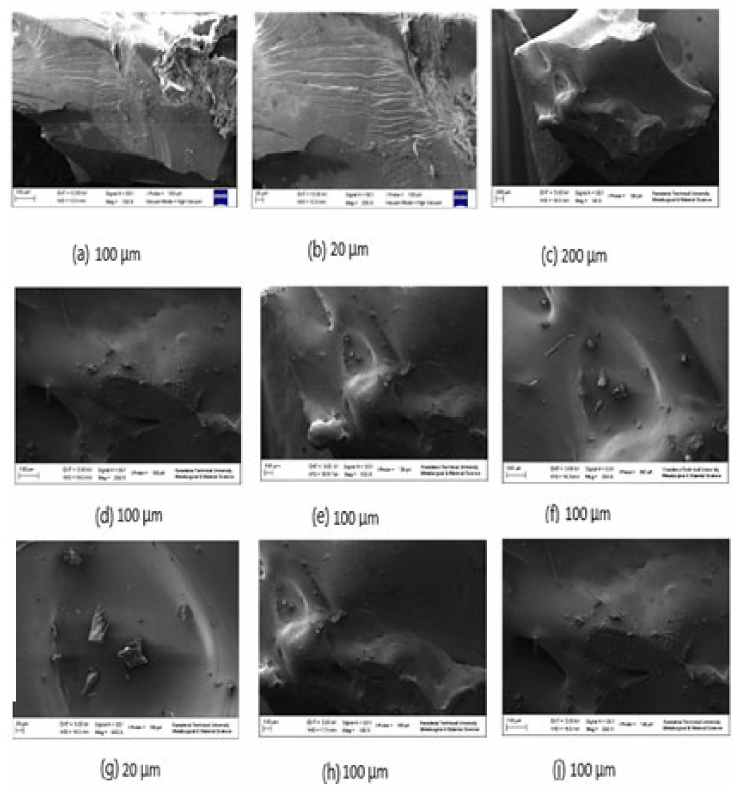
Figure 6. SEM pictures of P(AA / Kry23-DM) SAP ( a ) 100, ( b ) 20, ( c ) 200, ( d ) 100, ( e ) 100, ( f ) 100, ( g ) 20, ( h ) 100, ( j ) 100 in magnification ( µ